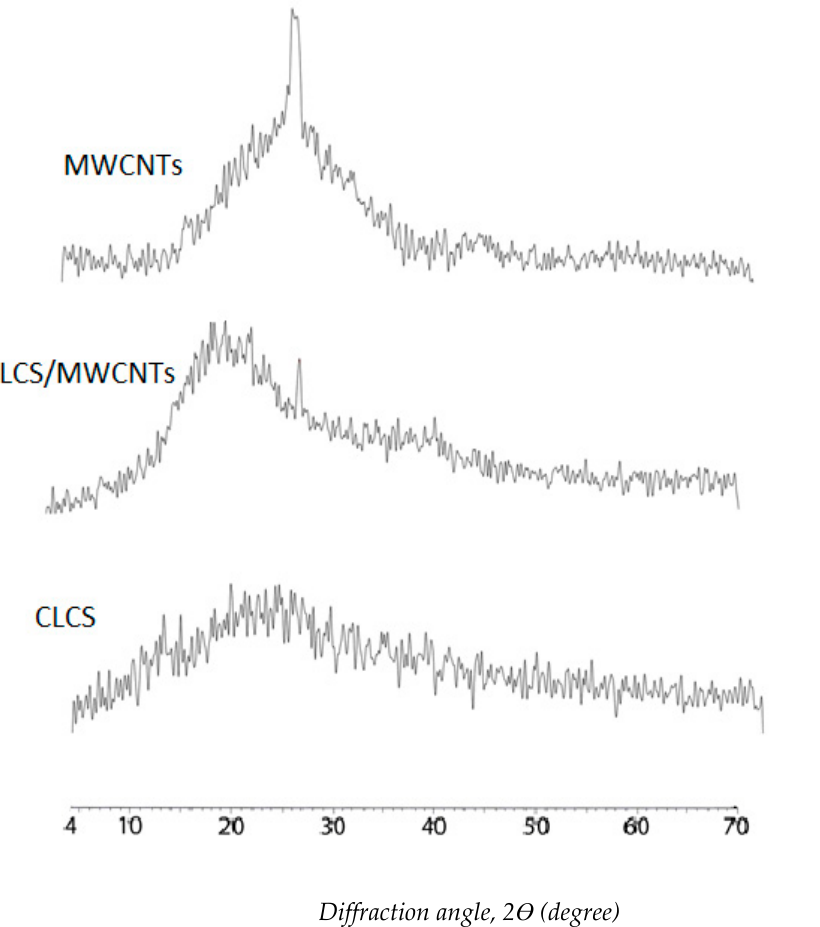
Figure 5. X-ray diffraction patterns of CLCS, CLCS/MWCNTs composite and MWCNTs.